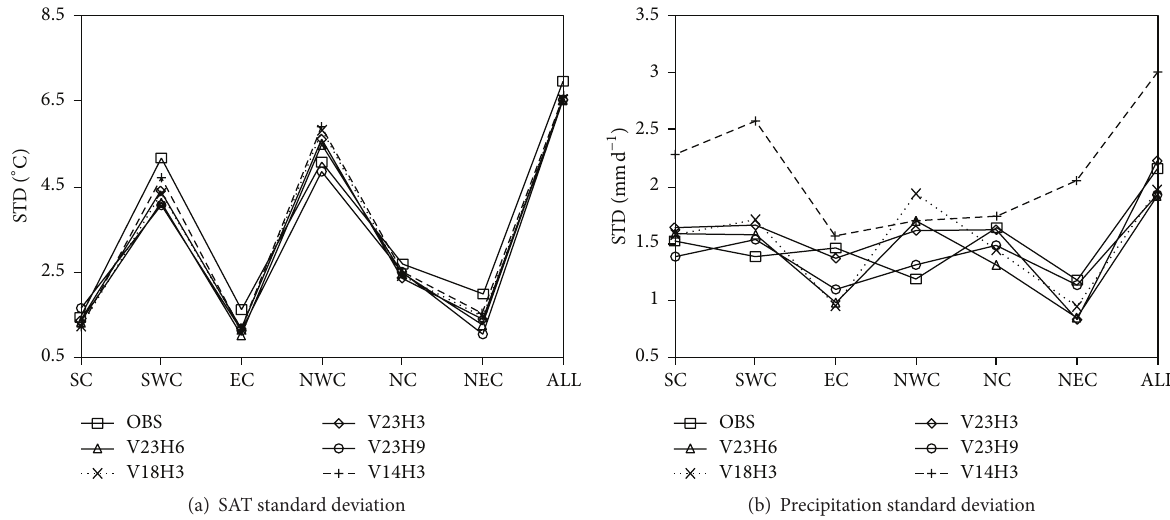
Figure 5: The standard deviation of SAT and precipitation at different resolutions in the studied